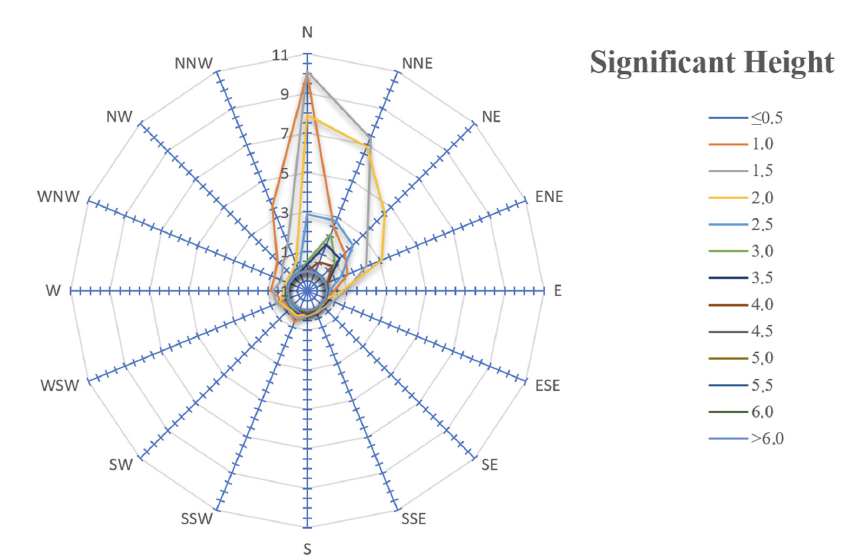
Figure 6. Porto Santo’s waves propagation direction. (Source: Authors). Regarding the predominant significant wave height, it appears that it is between 1.0 and 1.5 m, 10% of the times coming from the north and 7.5% of the times from the north- northeast, as can be observed in Figure 7.